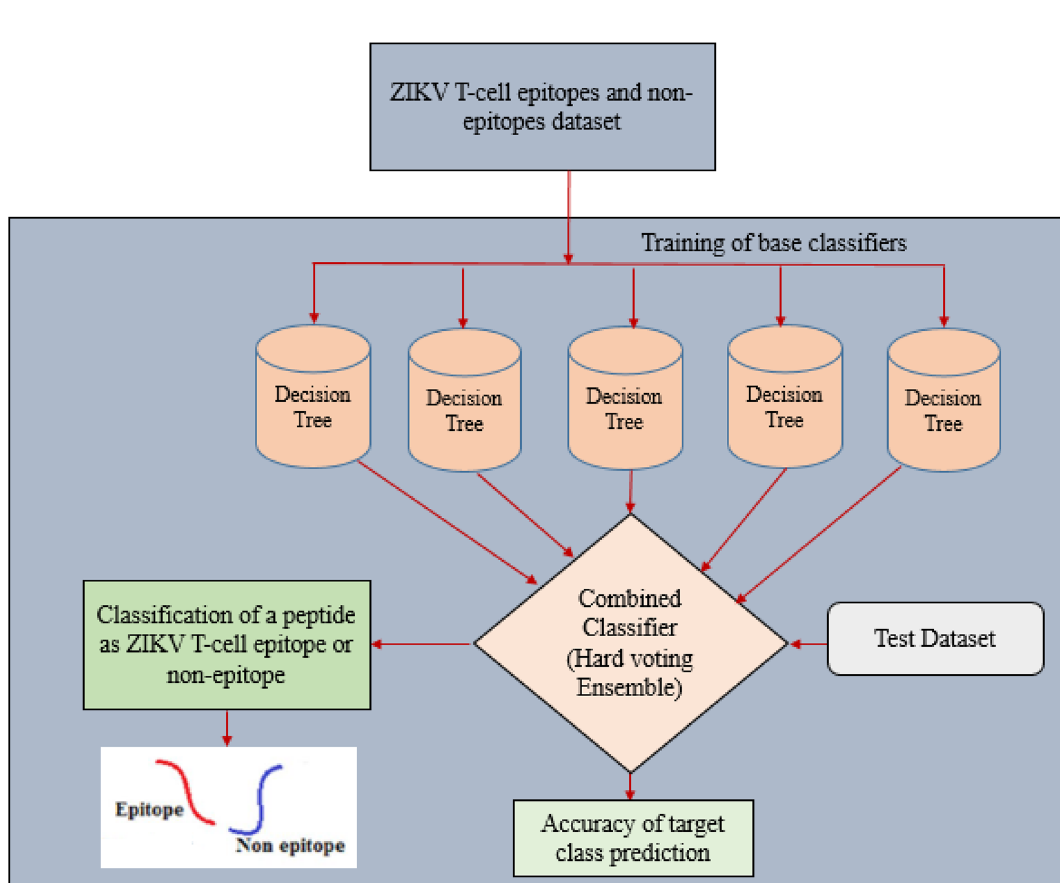
Figure 4. Proposed hard voting ensemble model for ZIKV T-cell epitope